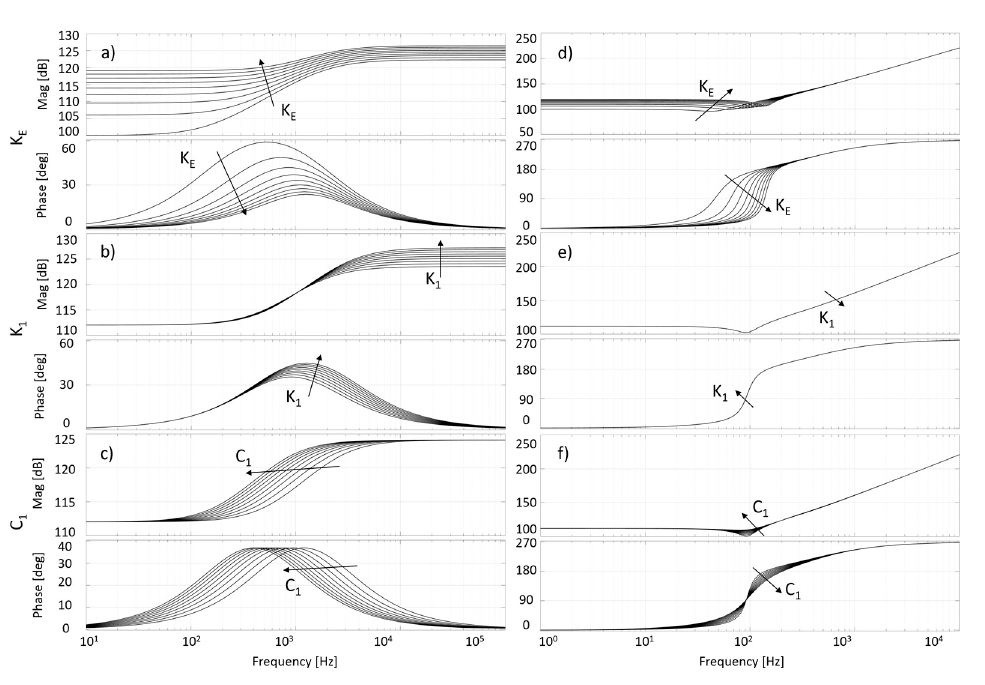
Figure 5. Sensitivity analysis on support parameters when considering Kelvin’s model. Left side ( a – c ): damper behavior as in Equation (3). Right side ( d – f ): F ACT / x behavior as in Equation (7). ( a ) Damper dynamic at varying K E . ( b ) Damper dynamic at varying K 1 . ( c ) Damper dynamic at varying C 1 . ( d ) F ACT / x at varying K E . ( e ) F ACT / x at varying K 1 . ( f ) F ACT / x at varying C 1